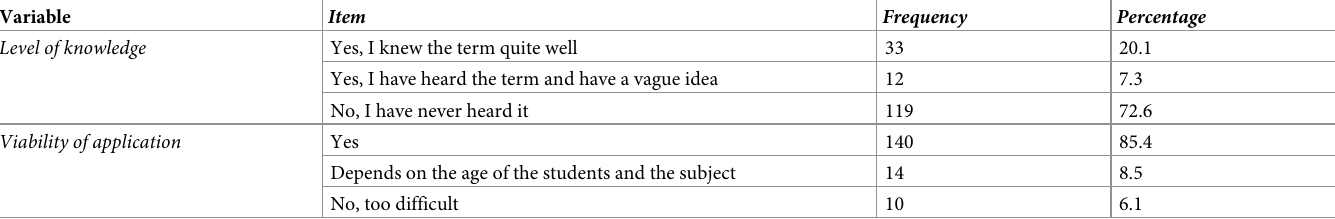
Table 2. Descriptive results of the level of knowledge and viability of application of gamification as an educational resource. Variable Level of knowledge